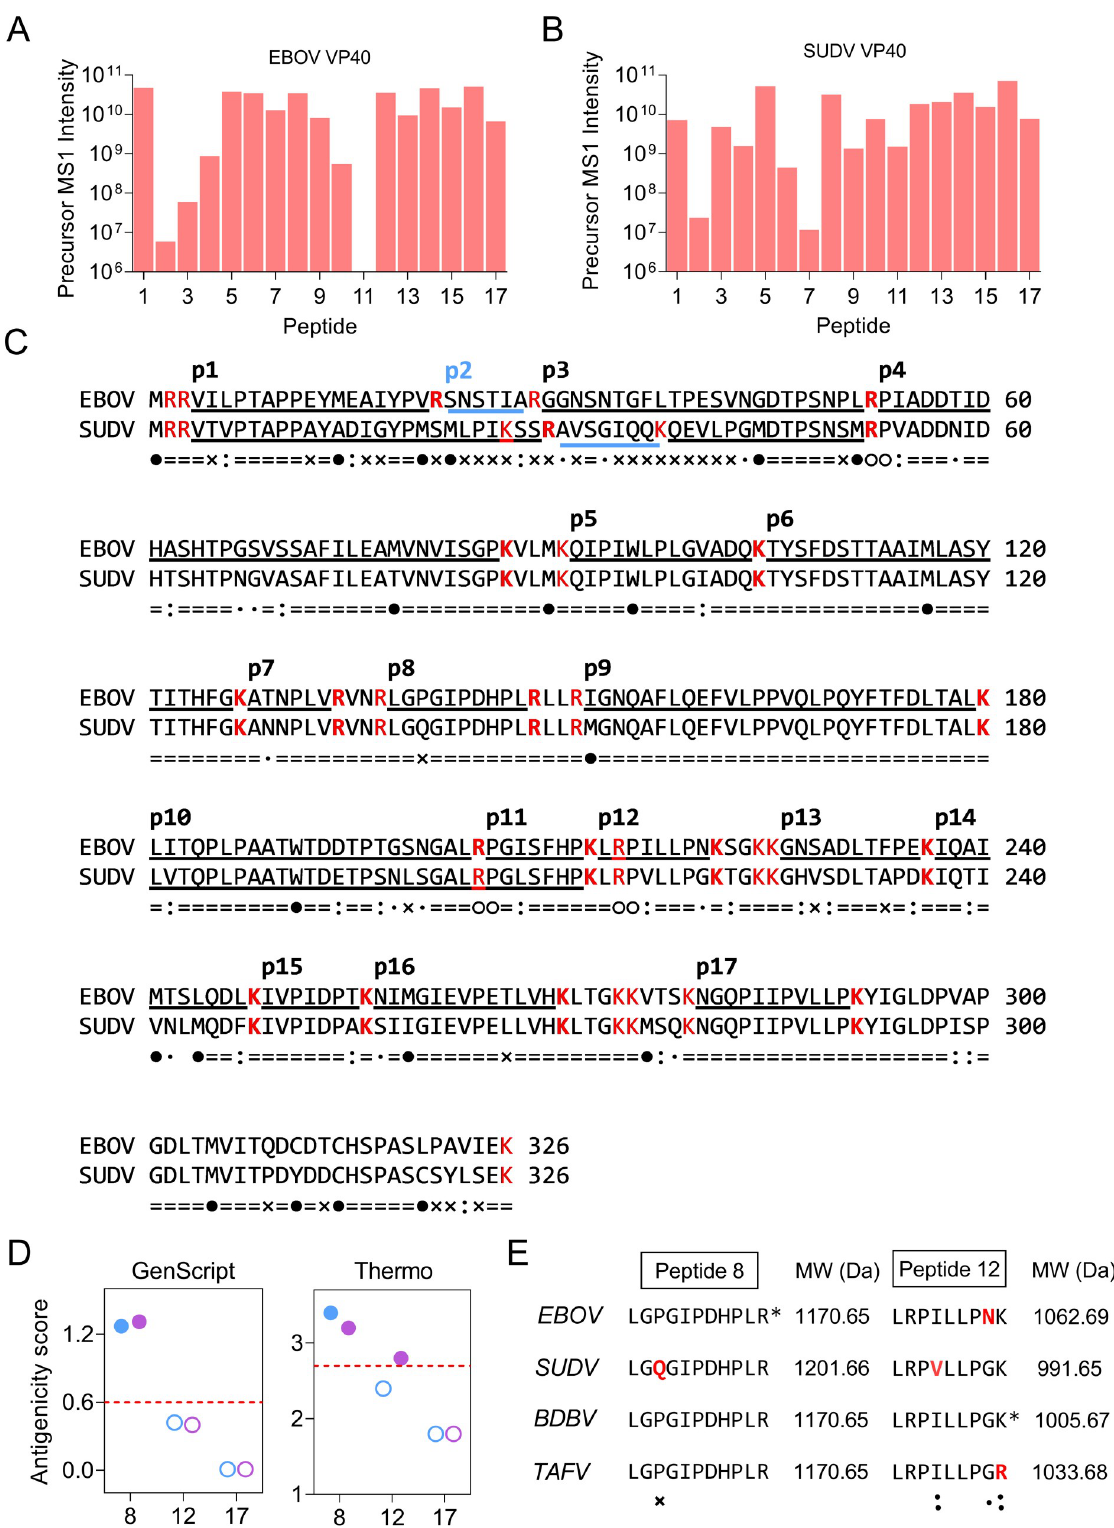
Fig 1. Selection of Ebolavirus peptides for species identification. (A-B) The tryptic peptides identified via LC-MS/MS derived from (A) EBOV and (B) SUDV recombinant VP40 protein. The precursor MS1 intensities are calculated in Maxquant software as the summed